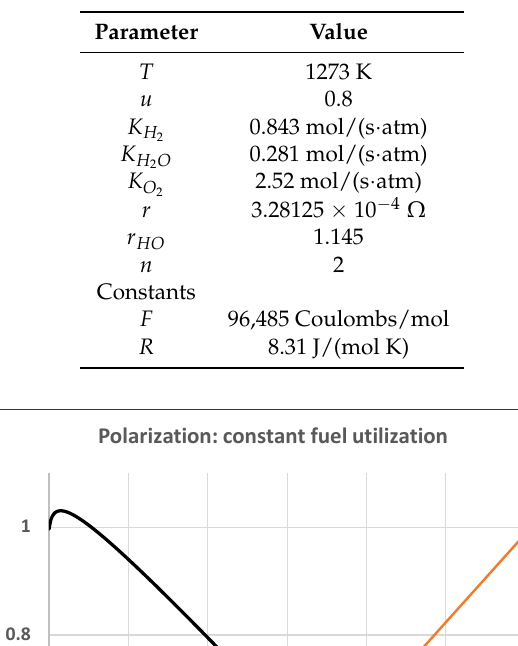
Table 1. Numerical values of parameters and constants.